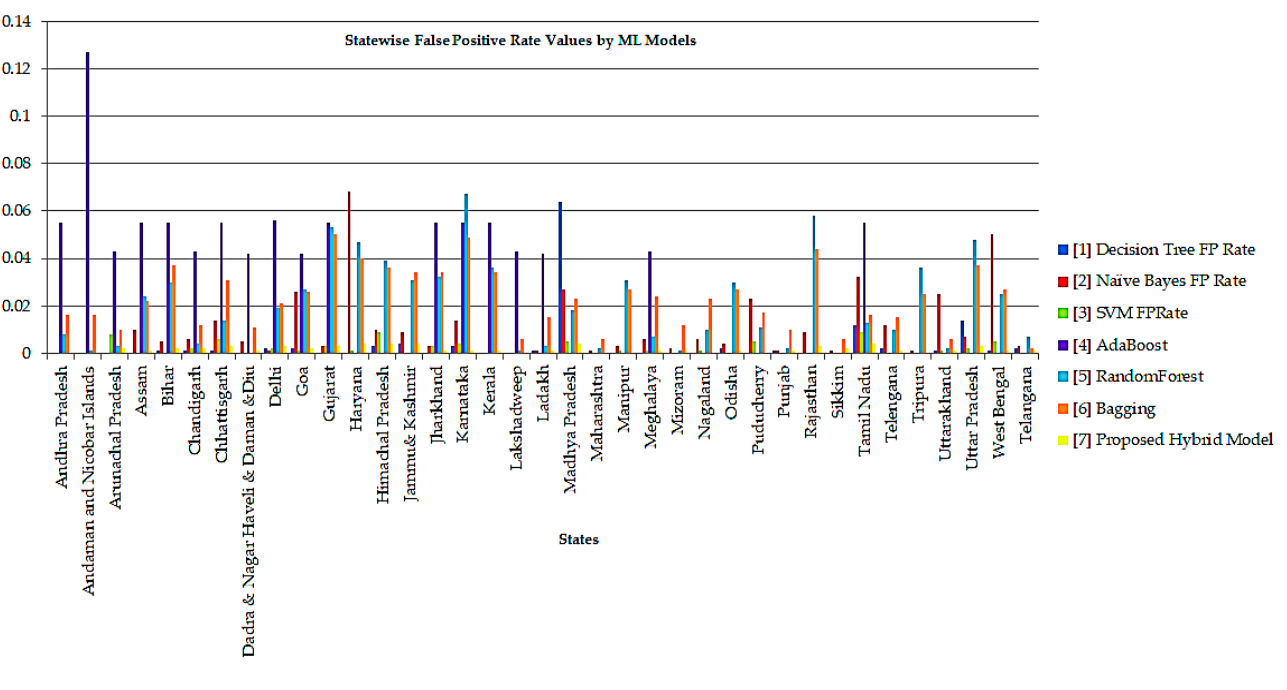
Figure 12. False Positive Rate Predicted by Classification Models for each class.